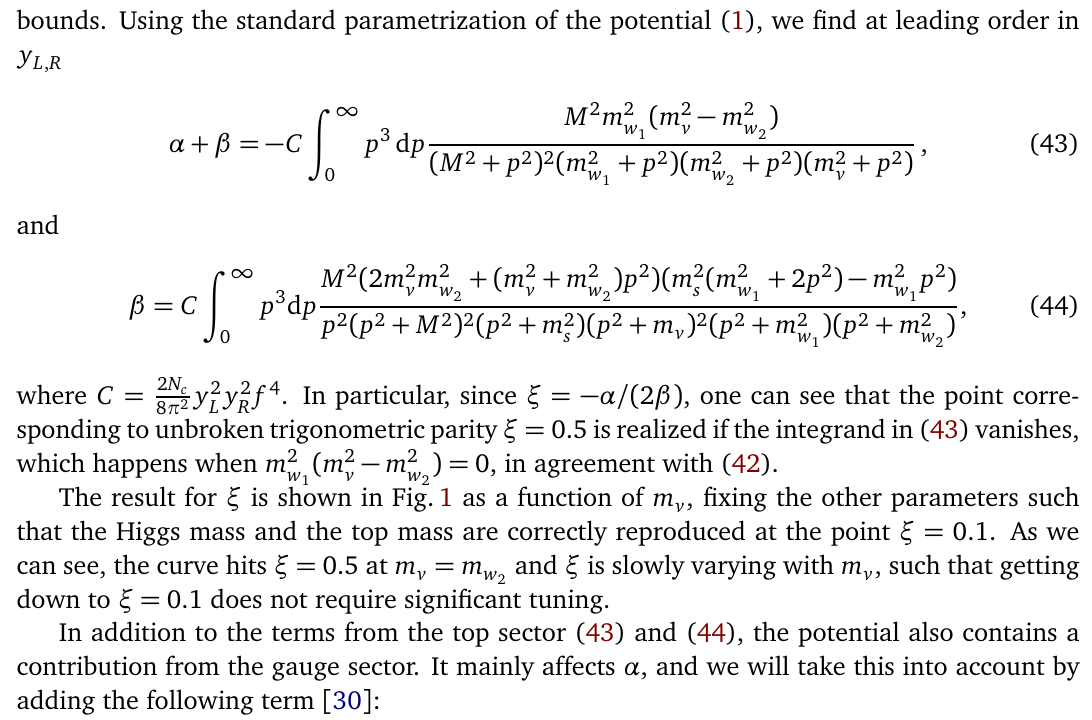
Figure 1: The value of ξ ≡ sin 2 ( 〈 h 〉 / f ) = − α/ 2 β as a function of m = m = 8 TeV, m = TeV, m w 1 w 2 s